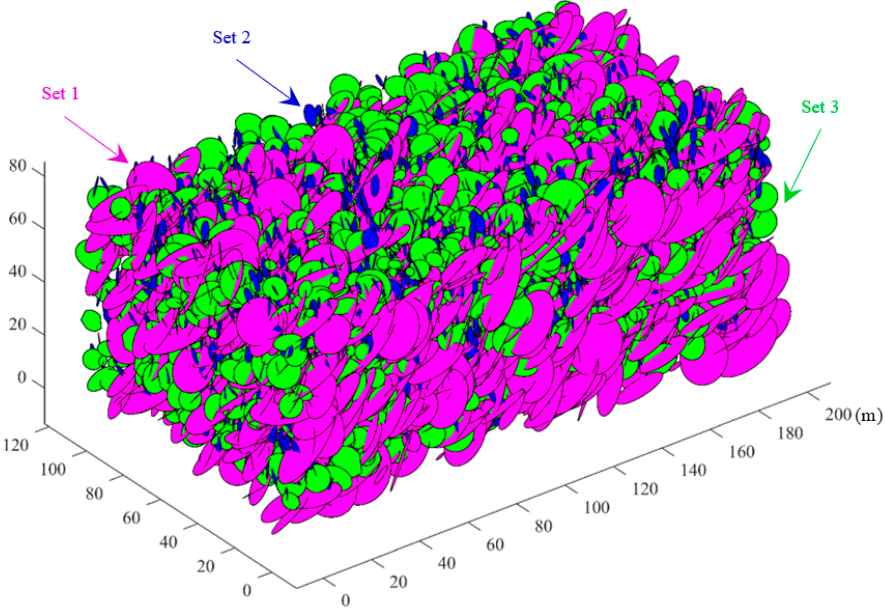
Figure 6. 3D fracture network model generated using the Monte Carlo method.